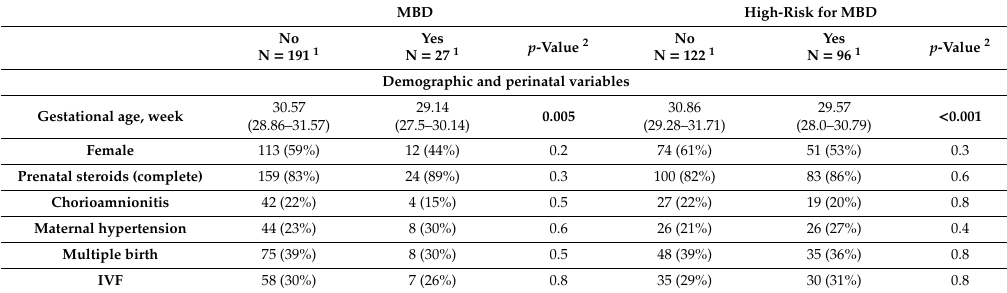
Table 2. Univariate analyses comparing infants with metabolic bone disease (cases) versus controls, and infants with a high versus low risk for metabolic bone